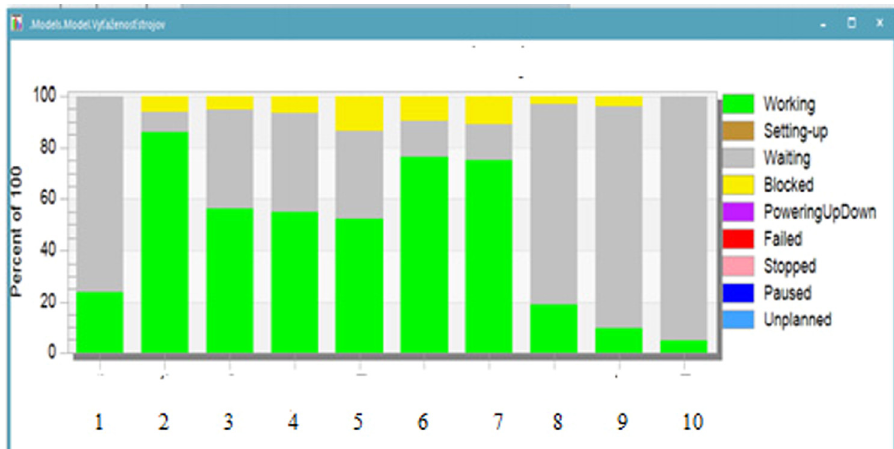
Figure 6: Utilization of devices ( device 1 – processing, 2 – dryer, 3 – planning, 4 – cutting, 5 – grinding, 6 – drilling, 7 – milling operation, 8 – gluing, 9 – surface treatment, and 10 – packaging ) . Source: authors.